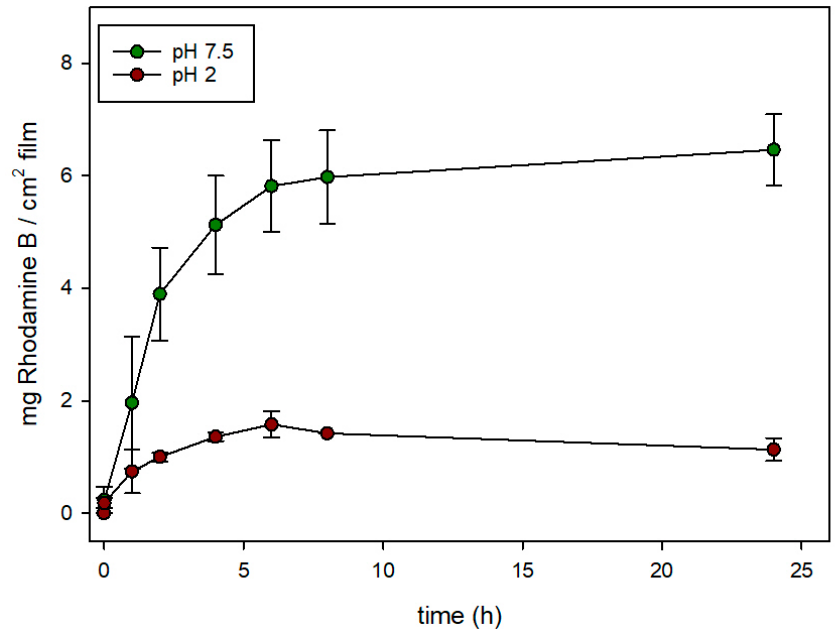
Figure 7. Evolution of rhodamine B release from EVOH 32-M-Rh-N3 prepared at pH 3 in aqueous media at acidic pH (pH = 2) and at neutral pH (pH =